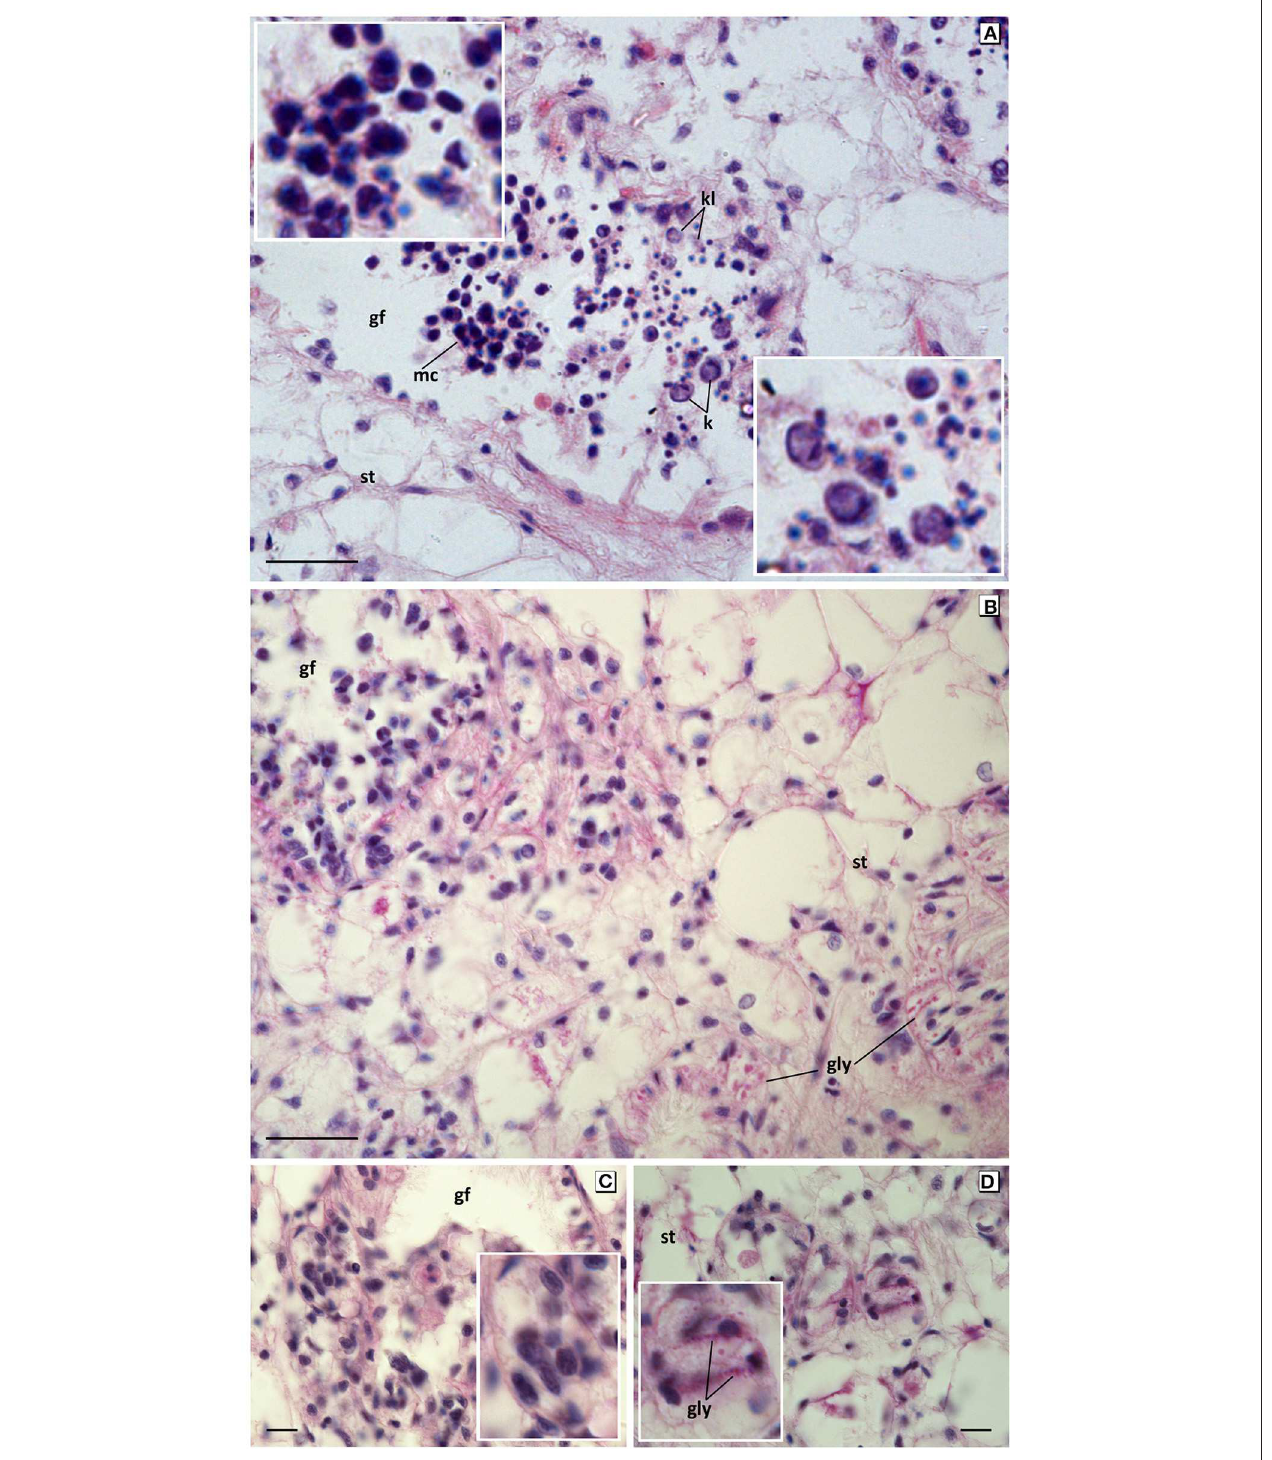
FIGURE 6 | Apoptotic and degenerative disorders in germinal cells from mussels exposed to 60mg L − 1 tar for 17 days. (A) Large mononucleate and multinucleated germinal cells whit big and irregular pyknotic nuclei (top inset), karyorrhesis and karyolisis (bottom inset). Haematoxylin and eosin stain. (B–D) Microcytic germ cells with hyperchromatic irregular nuclei, clear cytoplasm, and blurred edge forming encapsulated nodules, with deposits PAS positive in gonadal follicles and invading the connective tissue. PAS stain. Gf, Gonadal follicle; st, storage tissue; gly, glycogen; k, karyorrhexis; kl, karyolysis. Scale bar: 25 µ m (A,B) , 10 µ m (C,D) . Insets: 2x magnification in base